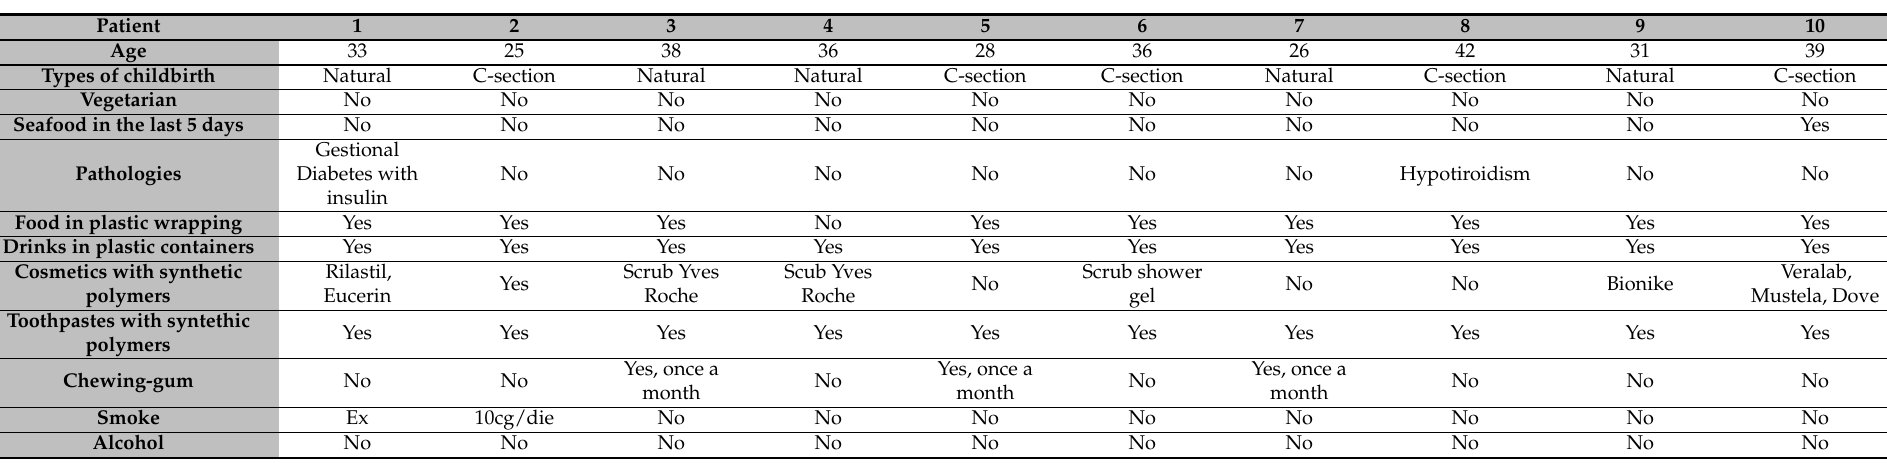
Table 1. Age, type of childbirth, lifestyle, routine habits of plastic consumption and pathophysiological conditions of the enrolled